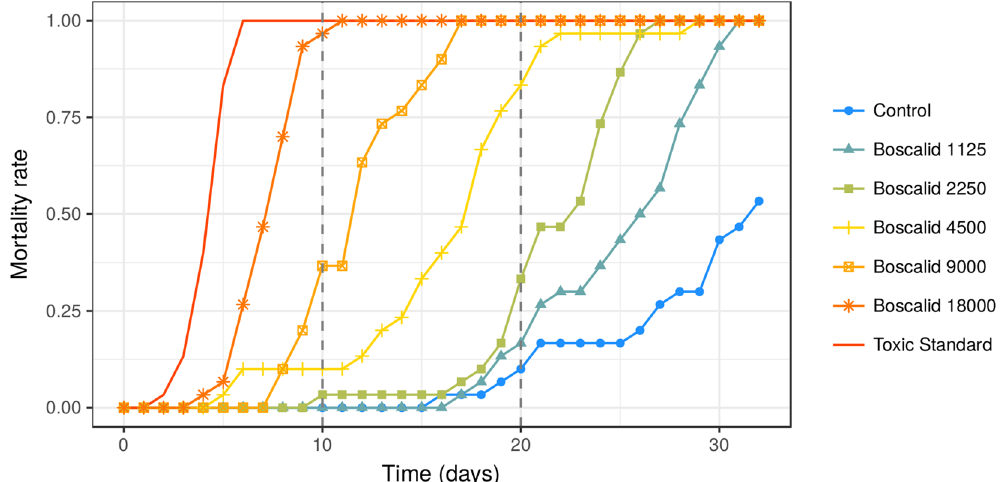
Figure 3. Observed mortality rate over the duration of the test. N = 30 bees per treatment, except for boscalid 9,000 mg/l, n = 29. Dashed vertical lines indicate ten days, i.e. duration of the test currently proposed by international standards, and 20 days, i.e. time at which the mortality in the control reached 15%. Current international standards (ten days) propose as validity criteria up to 15% mortality in the control group. Toxic standard was dimethoate at 1.5